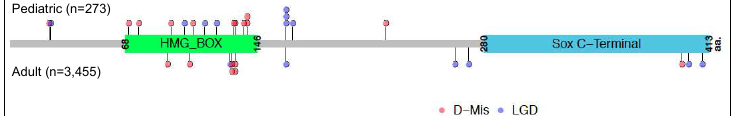
Figure 3. Locations of SOX17 likely gene disrupting (LGD) and rare predicted deleterious missense (D-Mis) variants carried by PAH cases from five cohorts from the US, UK and Japan. Variants carried